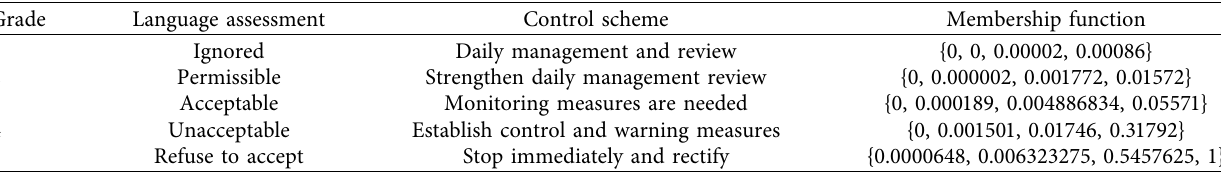
Table 15: Corresponding relation between risk grade standard and membership function (Risk Identification Framework).